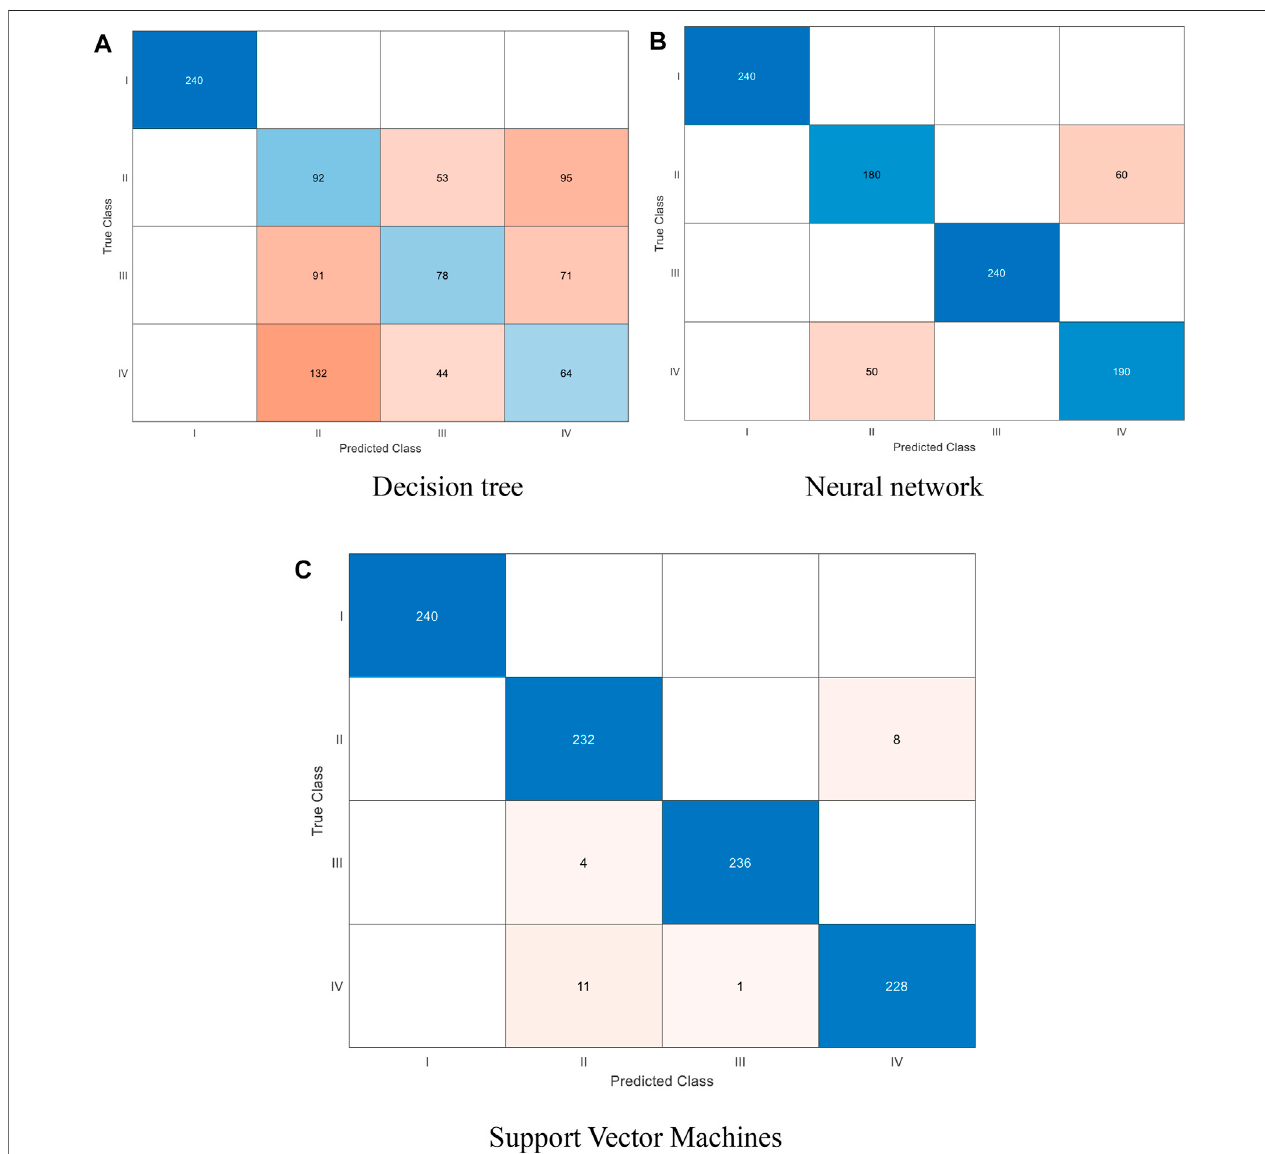
FIGURE 9 | True class and predicted class comparison diagram. (A) Decision tree, (B) Neural network and (C) Support Vector Machines.